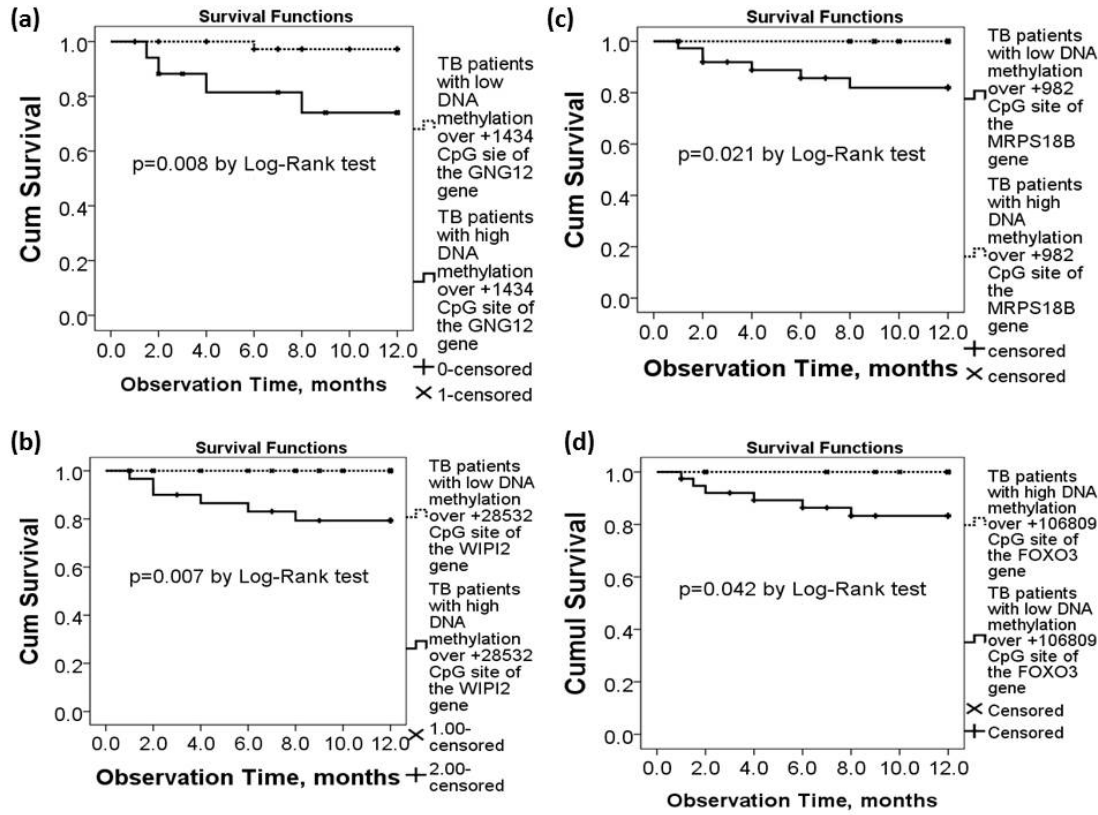
Figure 3. Differential DNA methylation levels of the WIPI2 , MRPS18B , FOXO3 , and GNG12 genes in association with long-term outcomes of the active TB patients in the validation cohort. ( a ) TB patients with high DNA methylation levels over the GNG12 (+1434 CpG site) gene had lower 1-year survival. Lower one-year survival rate was also noted in TB patients with ( b ) high DNA methylation levels over the WIPI2 (+28532 CpG site) gene, ( c ) low DNA methylation levels over the MRPS18B (+982 CpG site) gene, or ( d ) low DNA methylation levels over the FOXO3 (+106809 CpG site) gene.